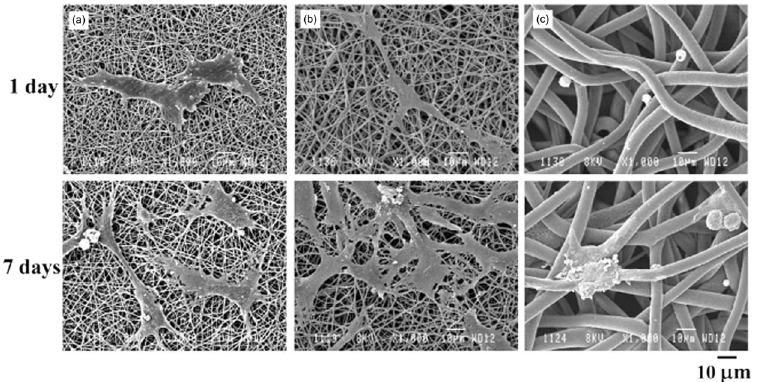
Figure 10: Soft lithography uses elastomeric stamp to replace hard stamp in traditional lithography to fabricate arrays of microstructures onto hydrogel surfaces ( reproduced from ref. [ 82 ])